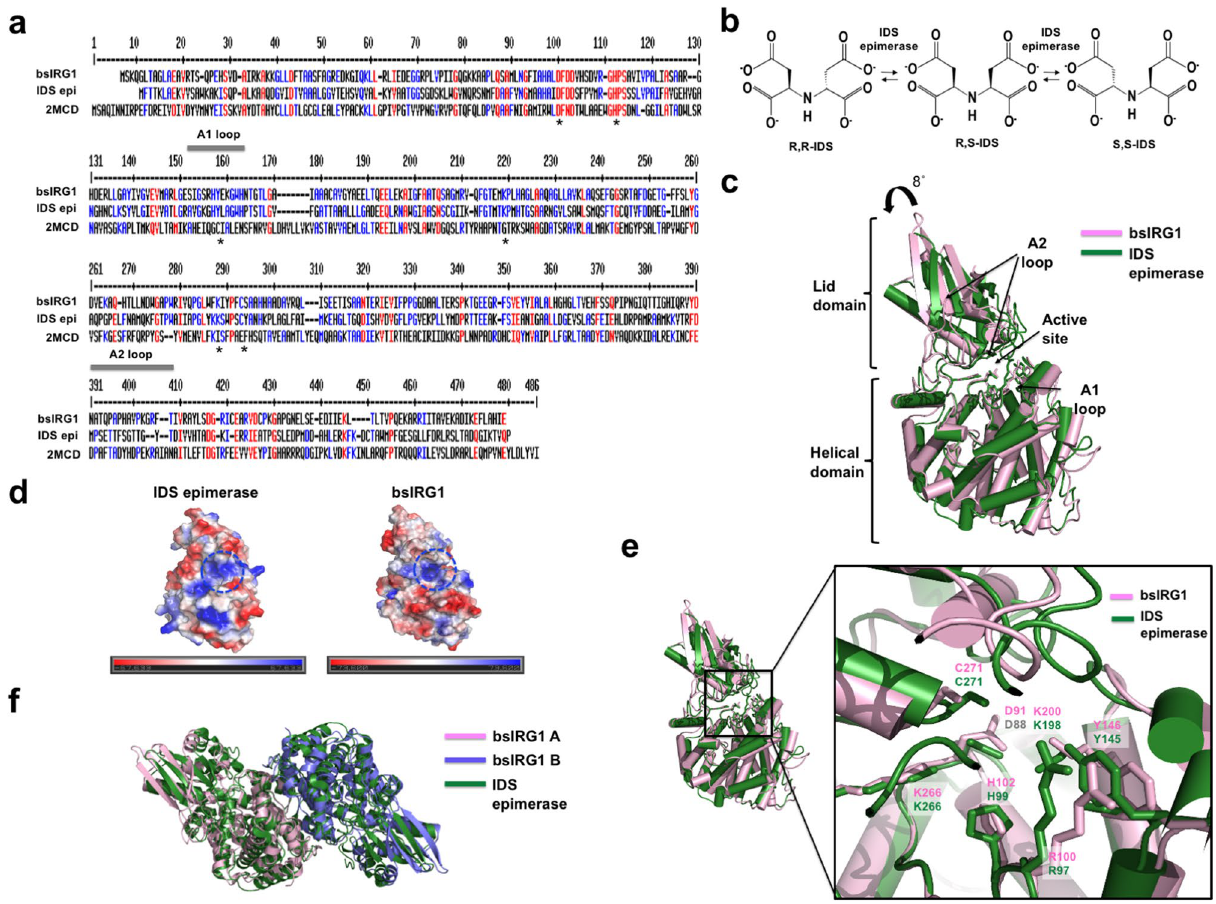
Figure 2. Structural comparison of Bacillus subtilis immune-responsive gene 1 (bsIRG1) with iminodisuccinate (IDS) epimerase. ( a ) Sequence alignment of bsIRG1 with IDS epimerase (IDS epi) and 2-methylcitrate dehydratase (2MCD), which are the most similar members of the citrate/2-methylcitrate dehydratase (MmgE)/2-methylcitrate dehydratase (PrpD) protein family. Completely conserved residues and partially conserved residues are indicated in red and blue, respectively. The star (*) symbols indicate the residues conserved in bsIRG1 and IDS epimerase, which are present in the active sites of those enzymes. The positions of the A1 and A2 loops are indicated by the gray bar above the corresponding sequences. ( b ) The production of IDS isomers catalyzed by IDS epimerase. ( c ) Superposition of the structure of bsIRG1 with IDS epimerase. The locations of active site and A1 and A2 loops are indicated. Based on the location of the lid domain of IDS epimerase, the rotation angle of the lid domain of bsIRG1 is also provided above the cartoon. ( d ) Electrostatic surface representation of IDS epimerase and bsIRG1. Blue circles indicate the active sites. ( e ) The details of the active site of bsIRG1 compared to that of IDS epimerase. The close-up view is provided in the right panel. The residues that form the active site are labeled. ( f ) Comparison of dimeric bsIRG1 with dimeric IDS epimerase by superposition